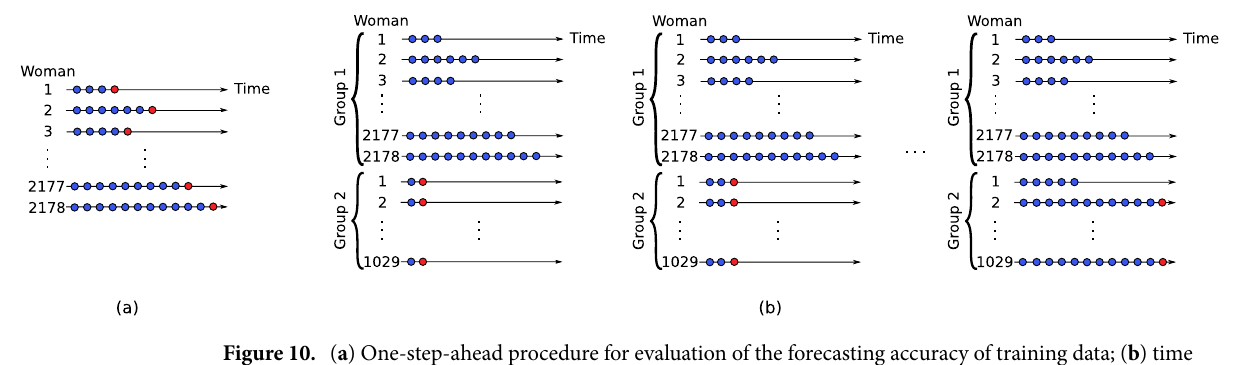
Figure 10. ( a ) One-step-ahead procedure for evaluation of the forecasting accuracy of training data; ( b ) time series cross validation for the test data as a function of cycle length. Training and test data are represented by blue and red circles